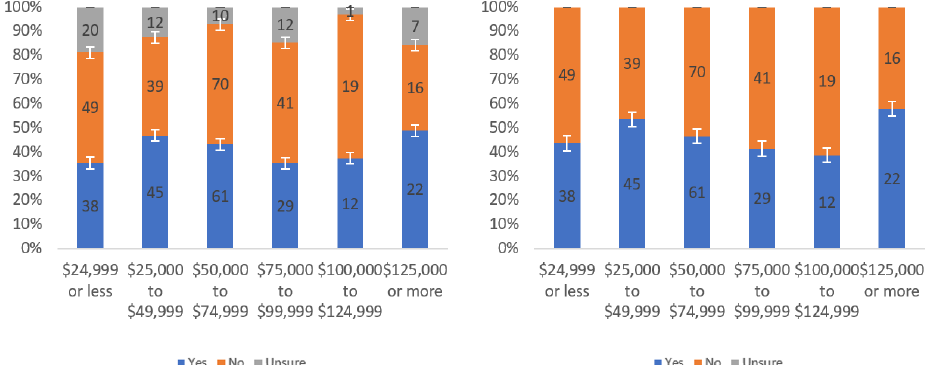
Figure A4. Responses regarding label annoyingness by income level including ( left ) and excluding ( right ) unsure responses.